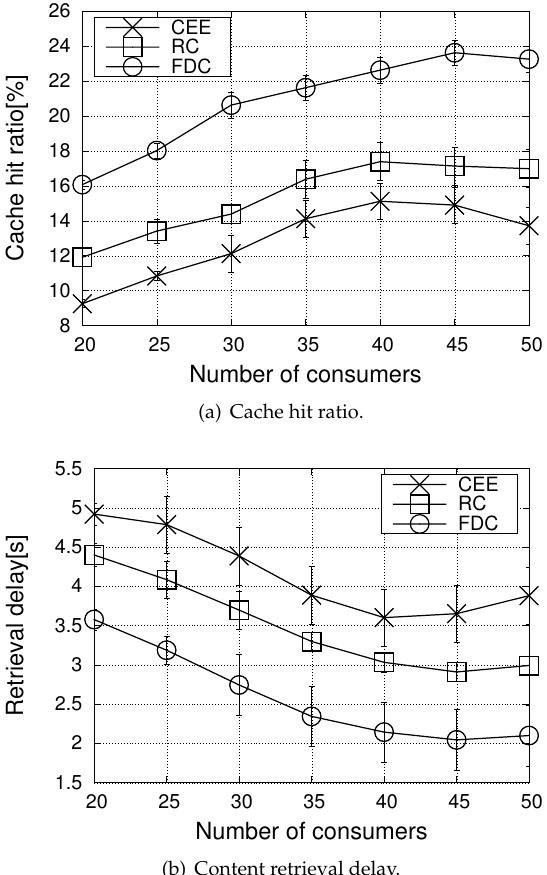
Figure 5. Performance metrics in the urban scenario, when varying the number of consumers ( α =